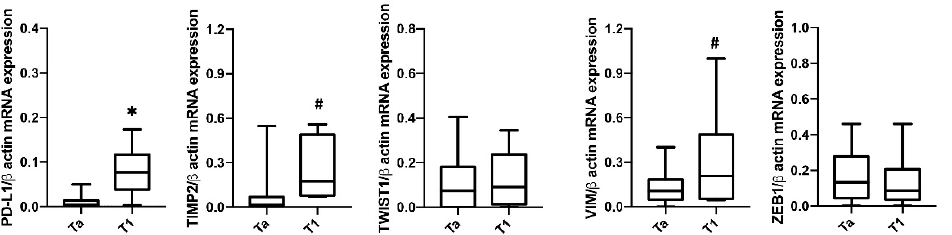
Figure 4. Expression of PD-L1 , TIMP2 , TWIST1 , ZEB1 and VIM in CTCs isolated from NMIBC pa ‐